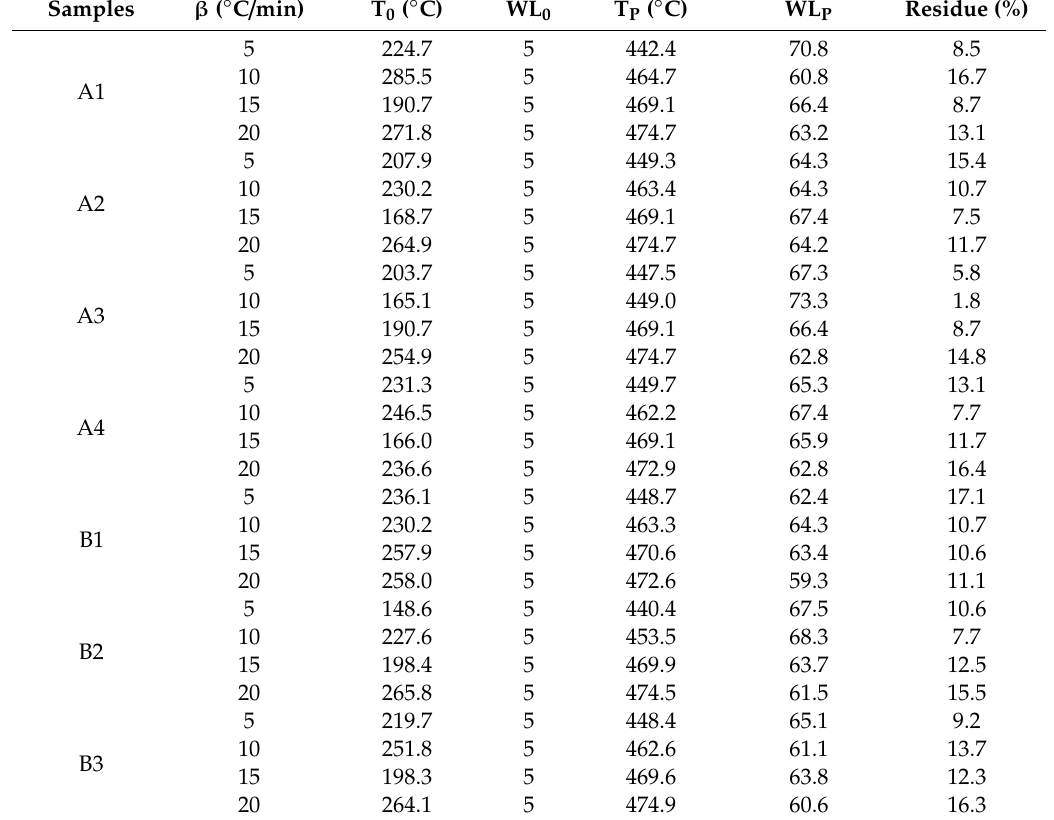
Table 4. Thermal decomposition parameters of the composite materials.